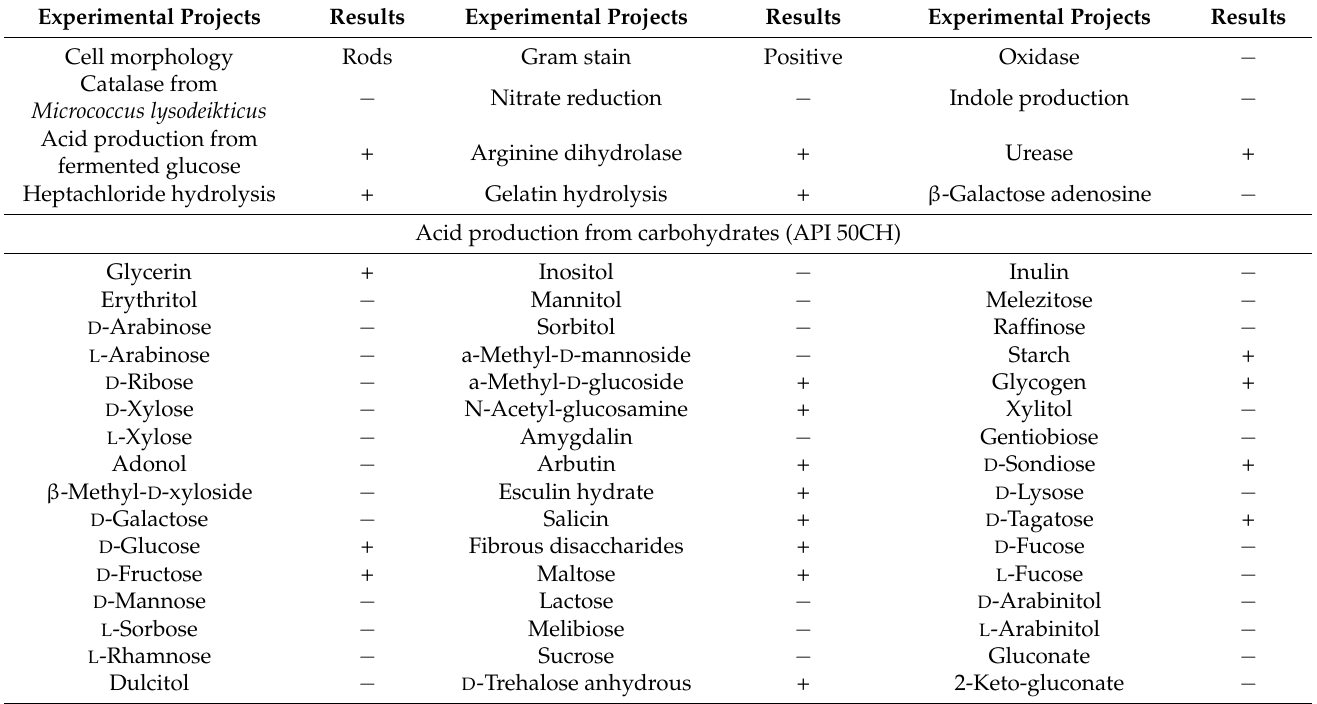
Table 1. Cellular morphological and physiochemical characteristics of